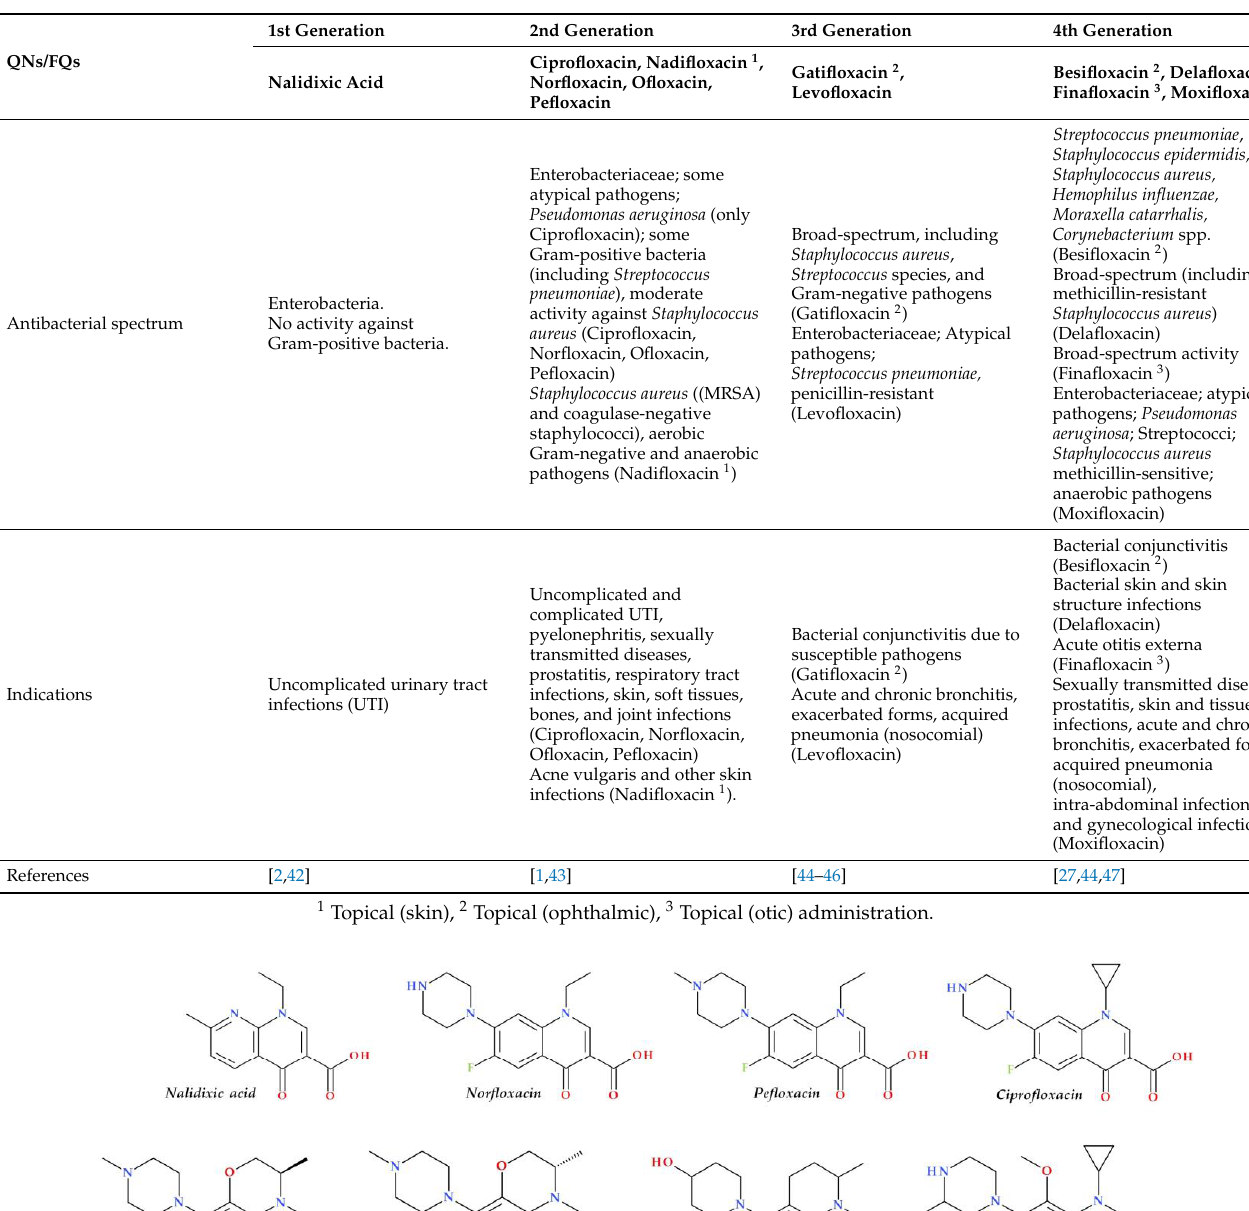
Table 1. QNs and FQs approved by the FDA and EMA from the perspective of the antibacterial spectrum and the main indications (EMA—European Medicine Agency, FDA—USA Food and Drug Administration, FQs—fluoroquinolones, QNs—antibacterial quinolones).